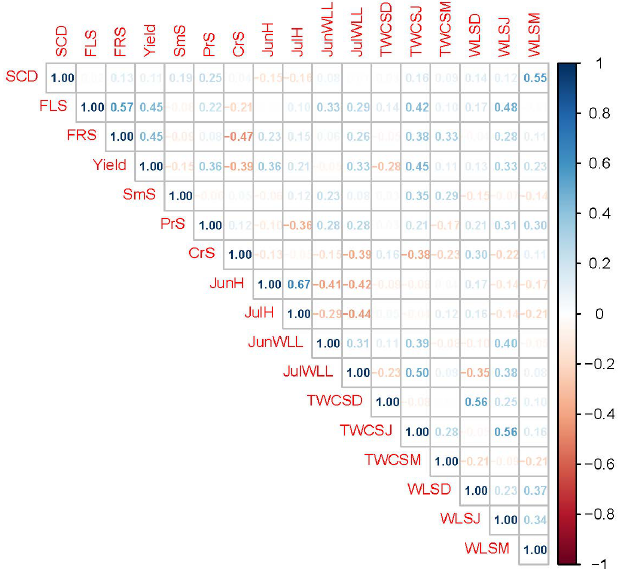
Figure 6. Correlation among biometric parameters, heat-resistant characteristics, and water regime traits of plant leaves and shoots of red currant plants. Abbreviations: SCD: Signs of Cold Damage;